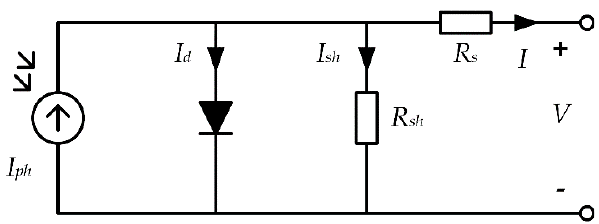
Figure 1. Equivalent circuit diagram for SDM.